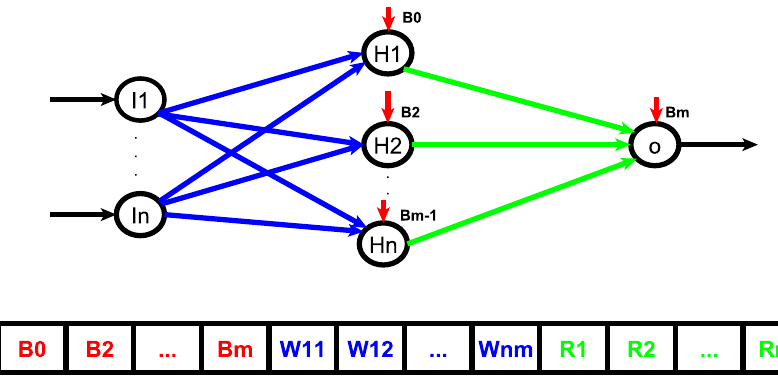
Figure 3. Assigning a salp to MLP.